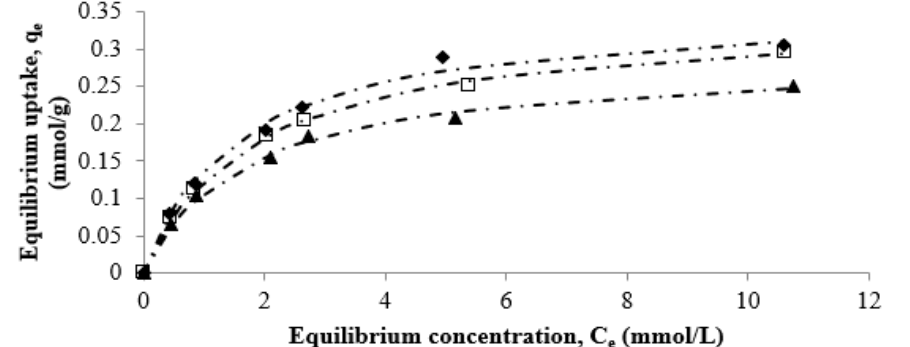
Figure 4. Effect of time and concentration on strontium adsorption onto the CF bead. The initial concentrations of the solution were ( ○ ) 1000, ( ∆ ) 500, ( □ ) 280, ( ● ) 220, (×) 100, and ( ■ ) 55 mg/L, respectively (pH: 6.5 and temperature: 298 K).